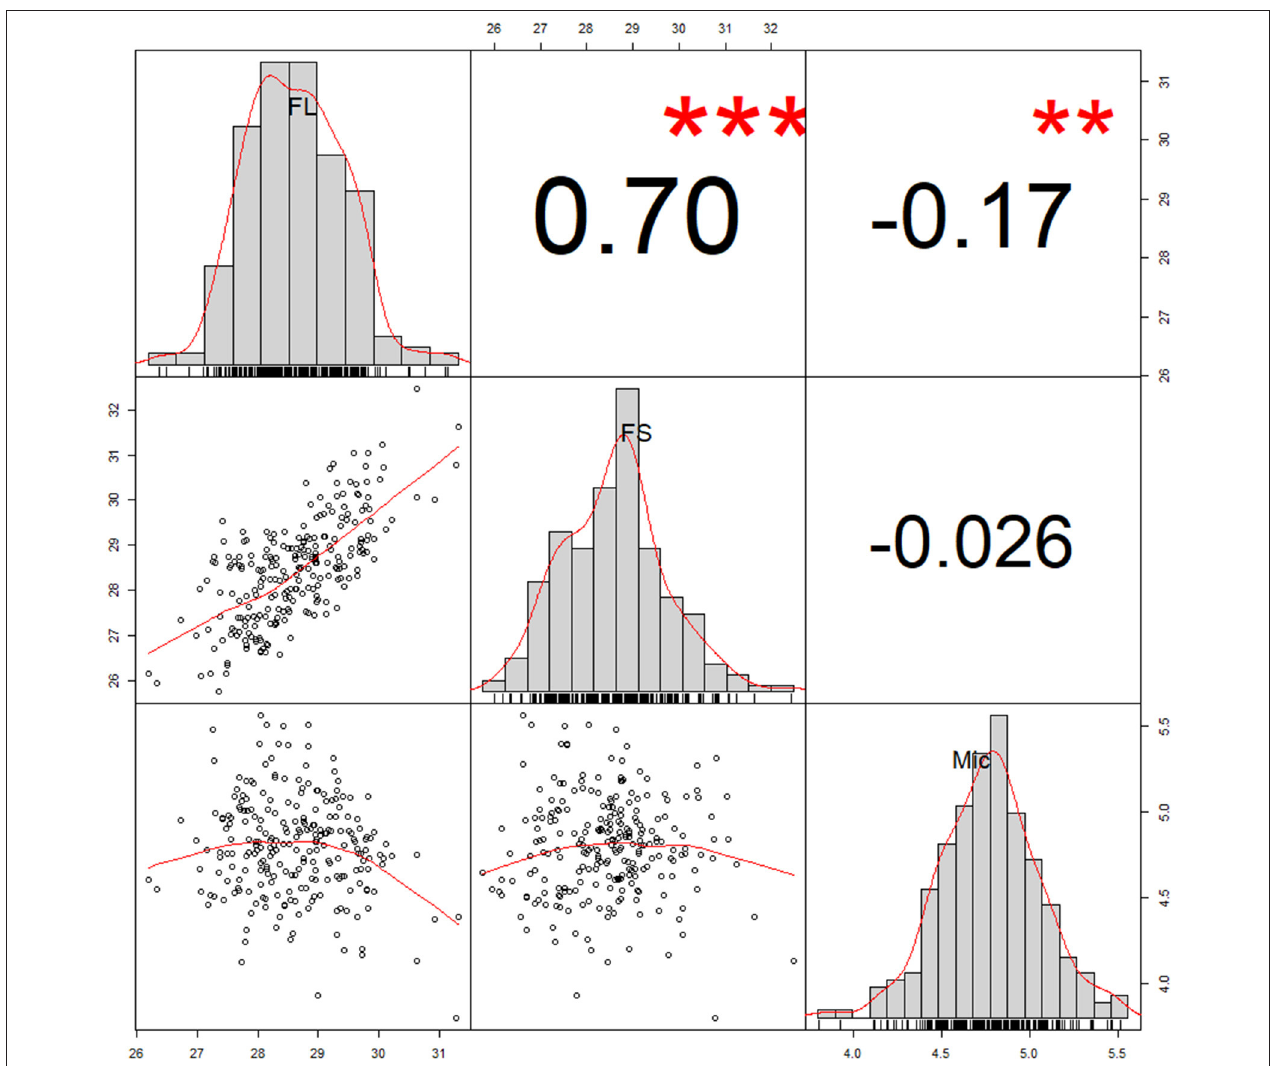
FIGURE 1 | Correlation analysis of three fiber quality traits. The number in these boxes indicated correlation coefficient (R value). The correlation coefficient and the significance between traits were conducted using Best Linear Unbiased Prediction (BLUP) values. ** P < 0.01, *** P < 0.001. FL, fiber length; FS, fiber strength; Mic, fiber